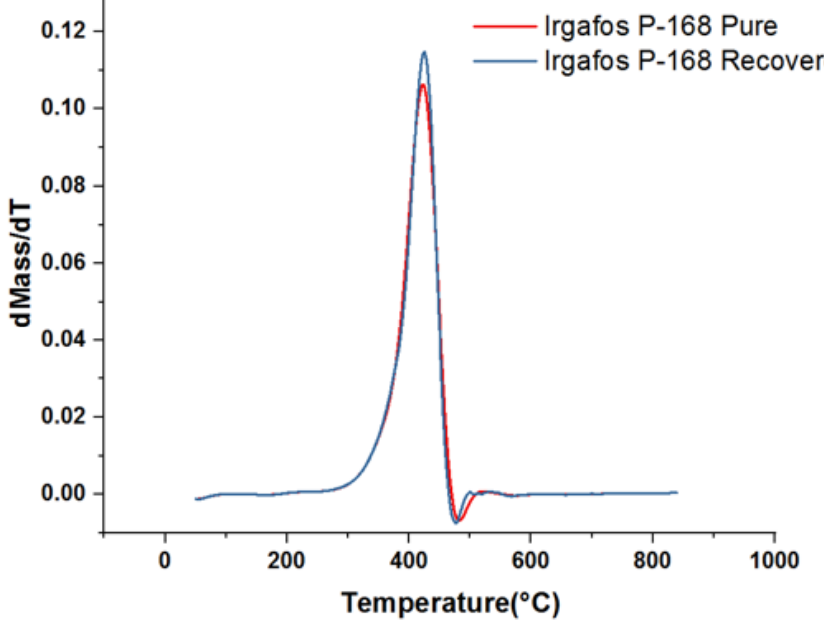
Figure 11. Derivative TGA of pure Irgafos and derivative TGA of recovered Irgafos.